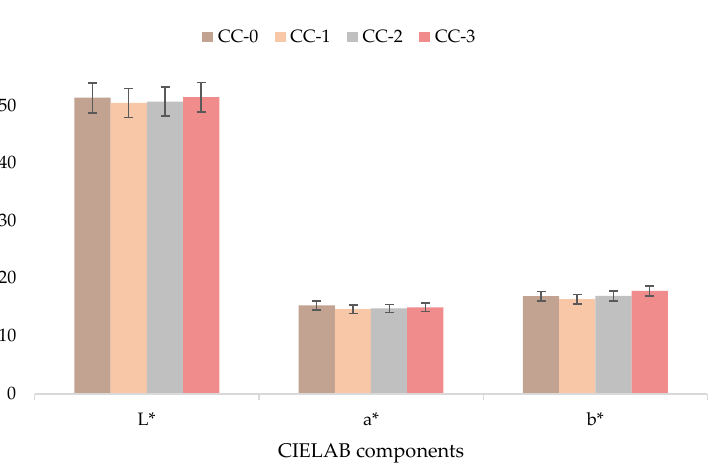
Figure 5. SEM micrographs of plasma-coated and untreated leather samples at 150×. ( a ) CC-0; ( b ) CC-3; ( c ) CC-6; ( d ) CC-12.